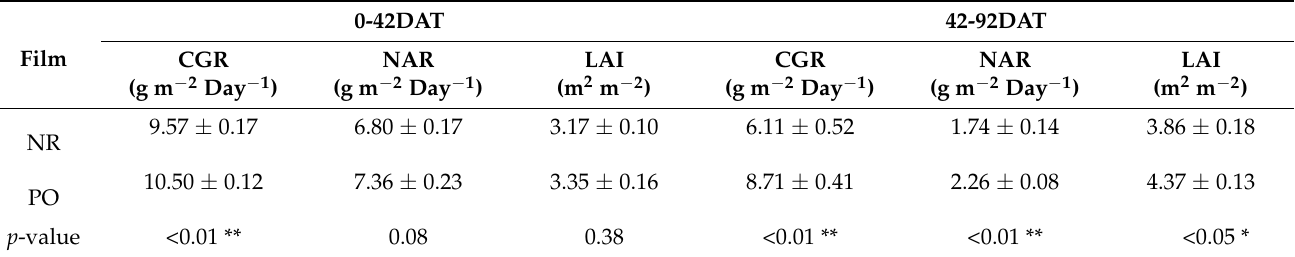
Table 3. Effects of high tunnel-covering film on the CGR, NAR, and LAI for plants between 0 and 42 DAT and between 42 and 92 DAT.